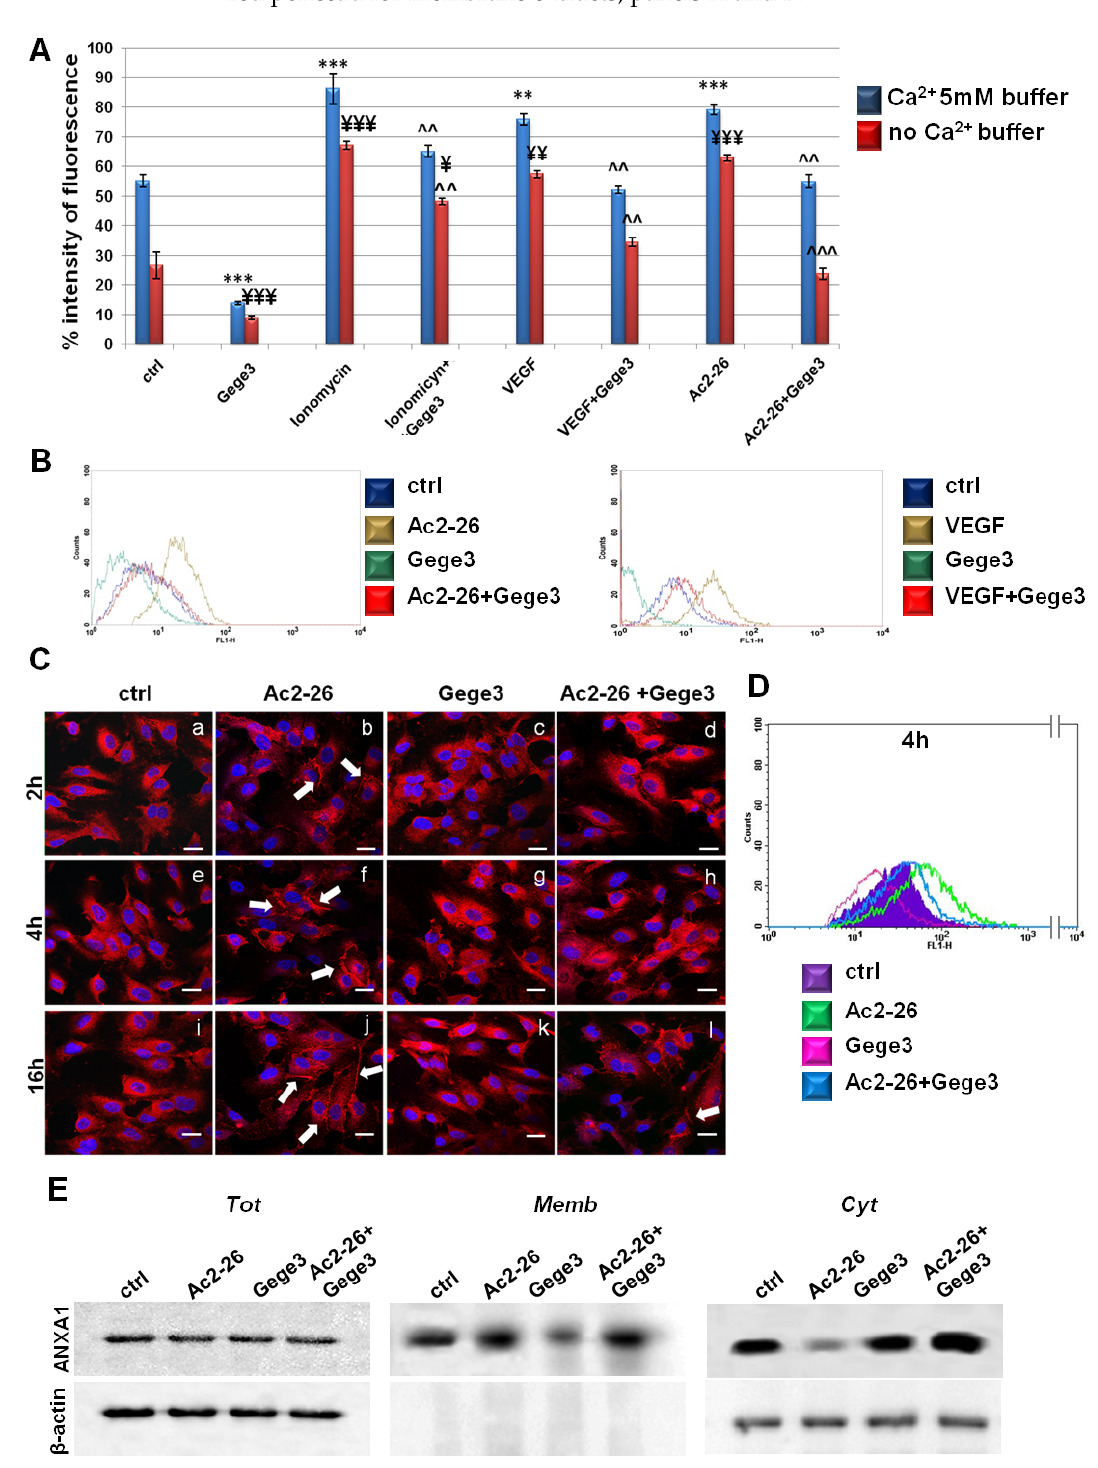
Figure 2. Analysis of Ca 2+ mobilization and ANXA1 localization in HUVEC cells. ( A ) Effects of Gege3 10 μM, ionomycin 1 mM with and without Gege3, VEGF 10 ng/mL with and without Gege3, and Ac-2-26 1 μM with and without Gege3, all monitored using the probe Fluo-4 a.m. In the histogram blue bars refer to the cytometry analysis of cells in PBS 1× complemented with CaCl 2 5 mM, red ones are related to the same experimental points evaluated in PBS 1× without calcium.